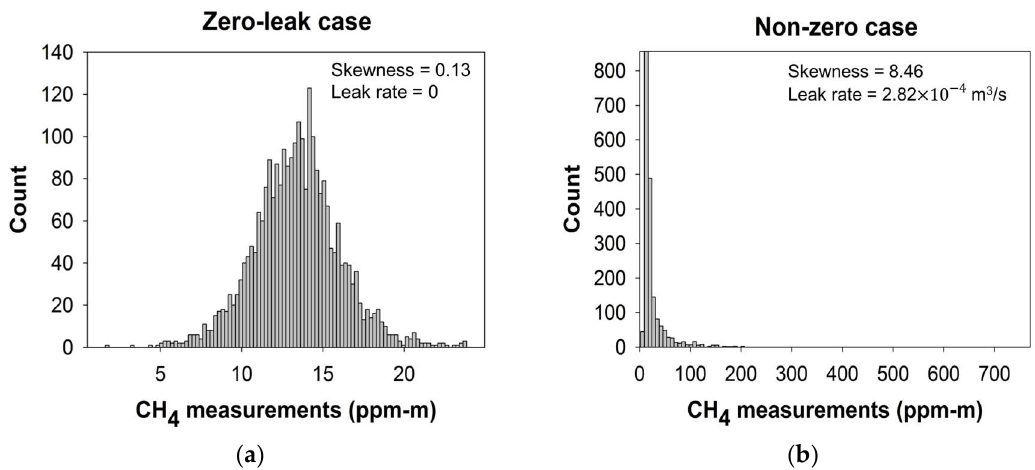
Figure 13. ( a ) Distribution of CH 4 measurements from a zero-leak case with a skewness of 0.13. ( b ) Distribution of CH 4 measurements from a non-zero-leak case (the leak rate is 2.82 × 10 − 4 m 3 /s) with a skewness of 8.46.